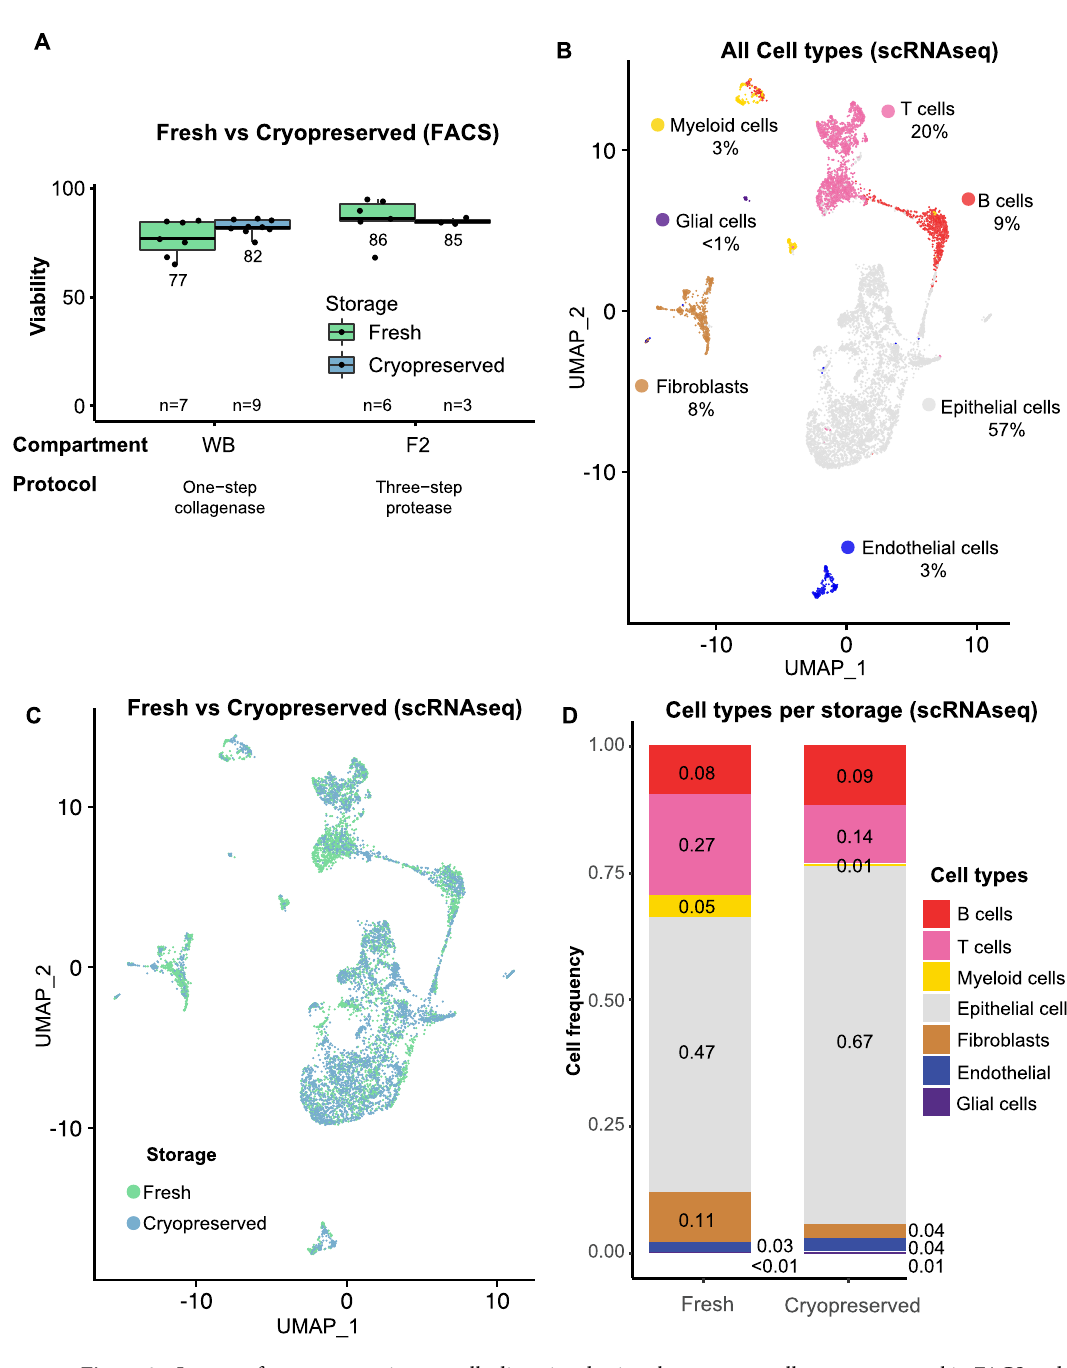
Figure 2. Impact of cryopreservation on cells dissociated using the one-step collagenase protocol in FACS and scRNA-seq. ( A ) Boxplots showing FACS cell viability (%) in dissociated cells from fresh versus cryopreserved samples for whole biopsy (one-step collagenase protocol) and fraction 2 (three-step protease protocol) (p-value > 0.05; non-paired t-test). Sample size is depicted in the lower part of the plot. UMAPs of scRNA-seq data obtained from two-paired fresh and cryopreserved samples dissociated with one-step collagenase colored by ( B ) cell types and ( C ) storage condition. ( D ) Bar plot of relative cell type frequencies recovered from the scRNA-seq data colored by